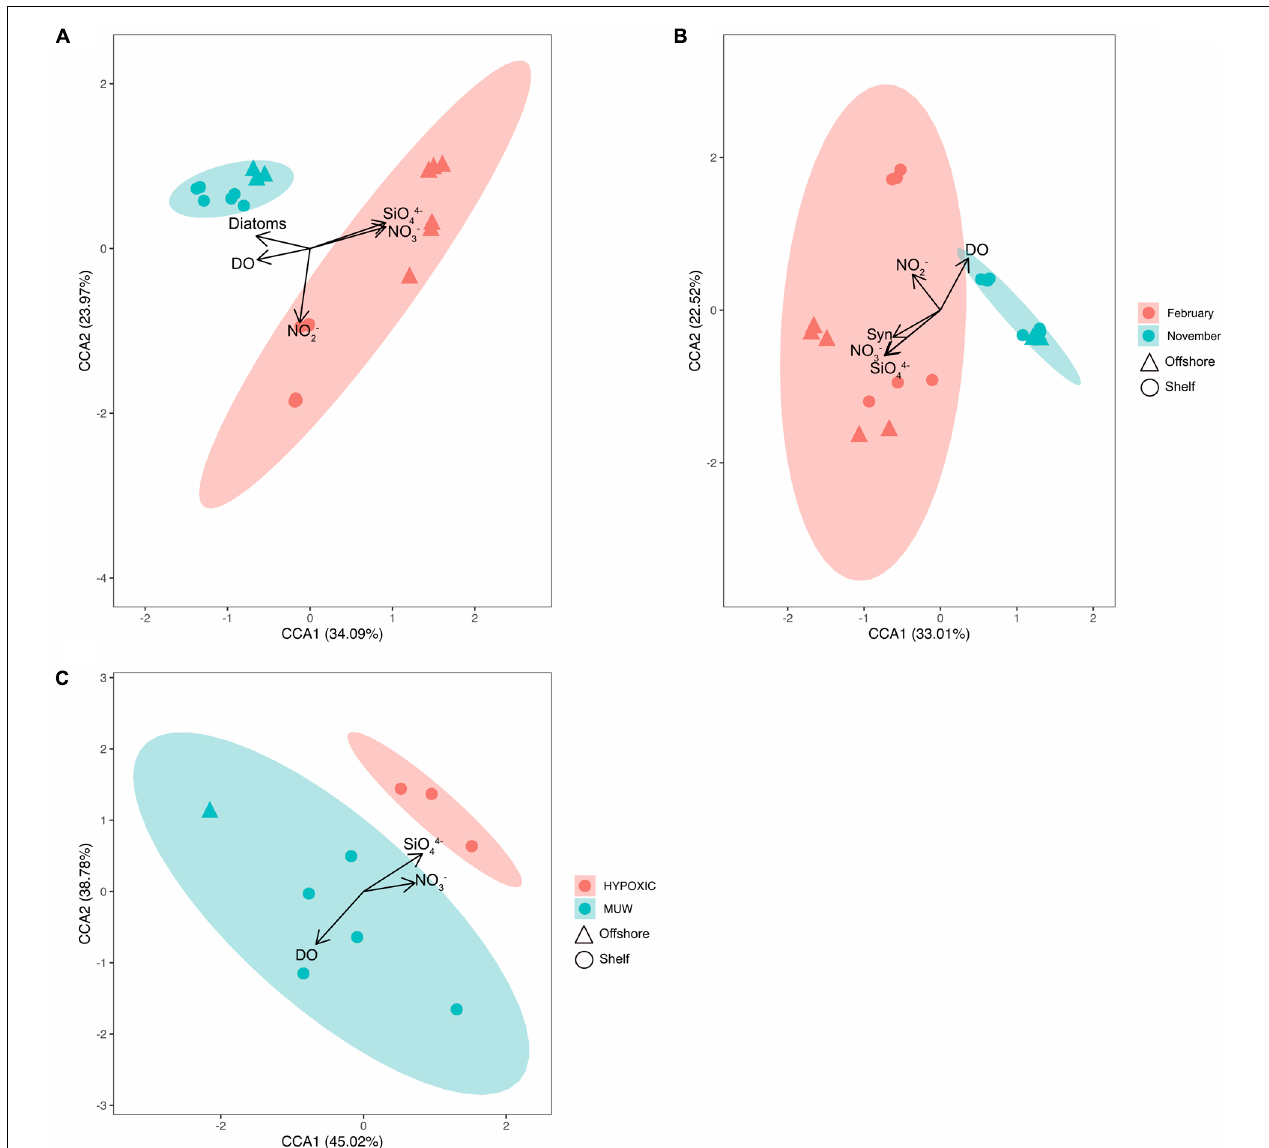
FIGURE 5 | CCA ordination plots grouping samples from (A) 16S data from November 2015 and February 2016, (B) 18S data from November 2015 and February 2016. (C) 16S data from May and September 2015. X and y axis show percent variability explained of the OTU distributions. Eigenvectors show how metavariables significantly influence the OTU distributions. Confidence ellipses indicating the mean of each centroid ( A,B by Month and C by watertype) are superimposed onto the plot. Syn, Synechococcus; DO, dissolved